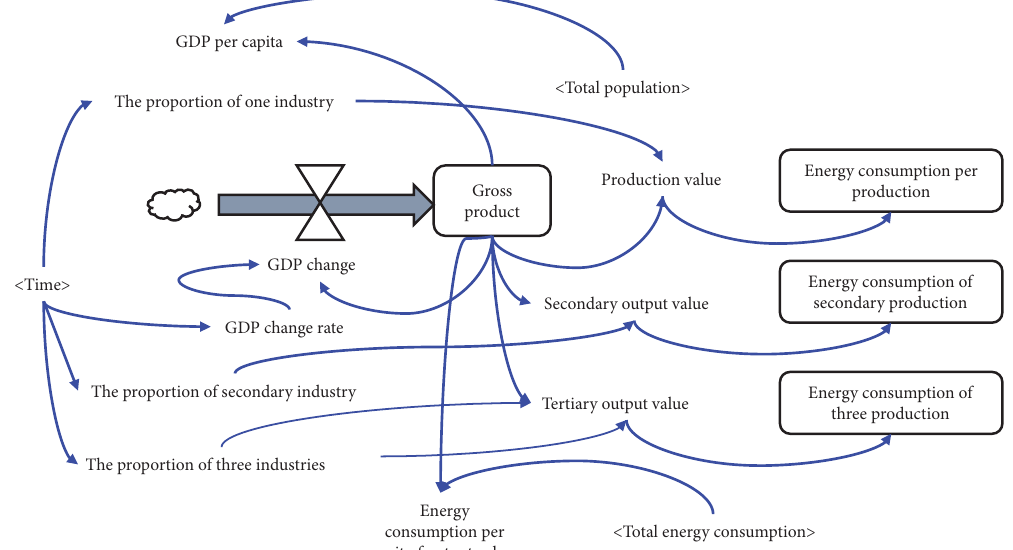
Figure 2: Flow chart of the economic